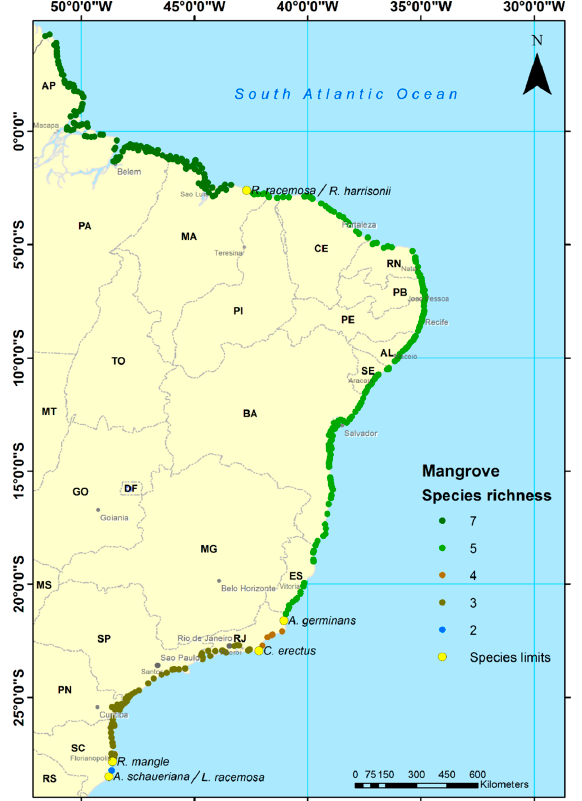
Figure 1. Mangrove species richness. The sample point distribution of Brazilian mangroves is colored by species richness ( n = 390) and the species limits are shown by yellow circles (detailed information in Table 1). Brazil has 16 coastal states with mangroves. Two-letter codes represent States, whereas dots represent our samples, both of which are given below between parentheses. In the north,